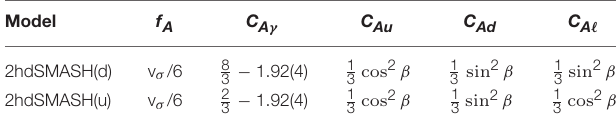
TABLE 2 | DFSZ-type axion predictions: axion decay constant f A , coupling to the photon C A γ , and tree-level couplings to quarks and charged leptons C Ai , i u ,..., t , e ,.., τ , with tan β v u / v d = ≡